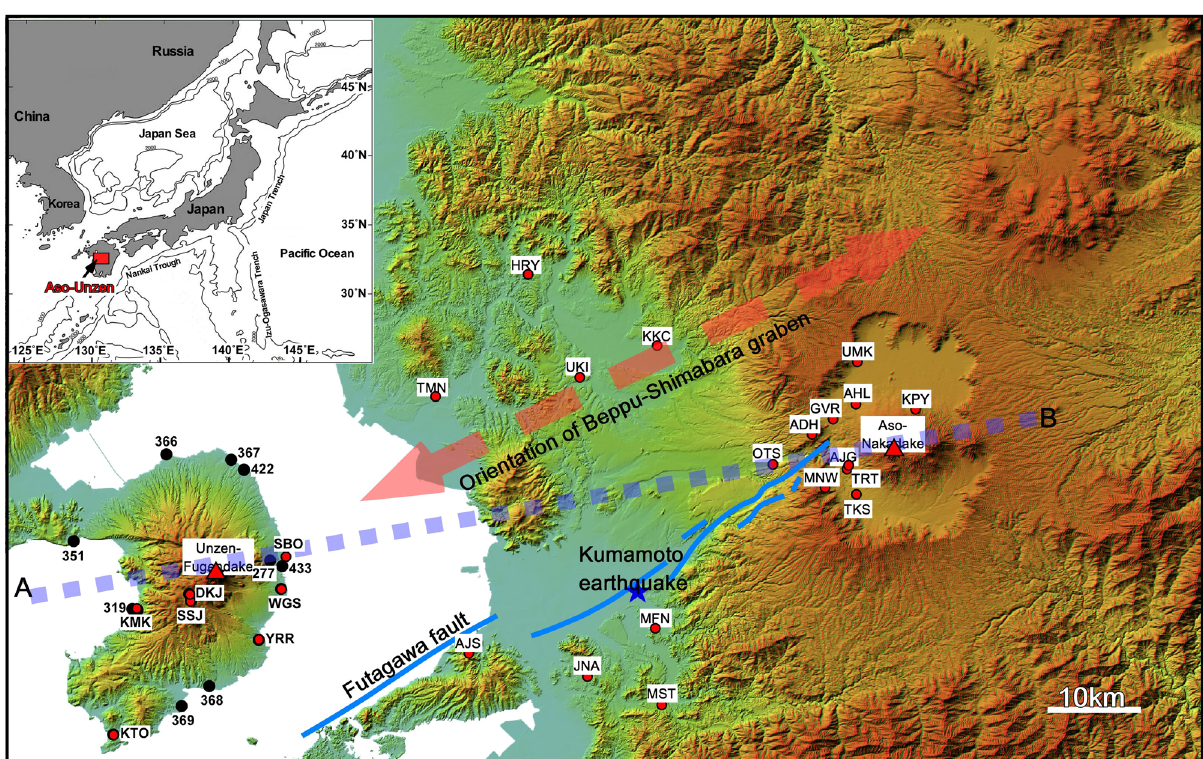
Fig. 1 Location of sampling sites. Location of sampling sites (red dots) at the inside and outside of Mt. Aso caldera together with around Mt. Unzen. Those of black dots are referred from Morikawa et al. (ref. 14 ). Abbreviations of symbols are explained in Table S1 and S3. Blue star and thick dashed line show epicenter of the 2016 Kumamoto earthquake (M7.3) and the location of seismic tomography image in Fig. 3, respectively. Orientation of the Beppu- Shimabara graben and Futagawa faults are shown by thick dotted red allow and blue solid curves. The base map is modi fi ed from Digital Japan Portal Web Site, Geospatial Information Authority of Japan